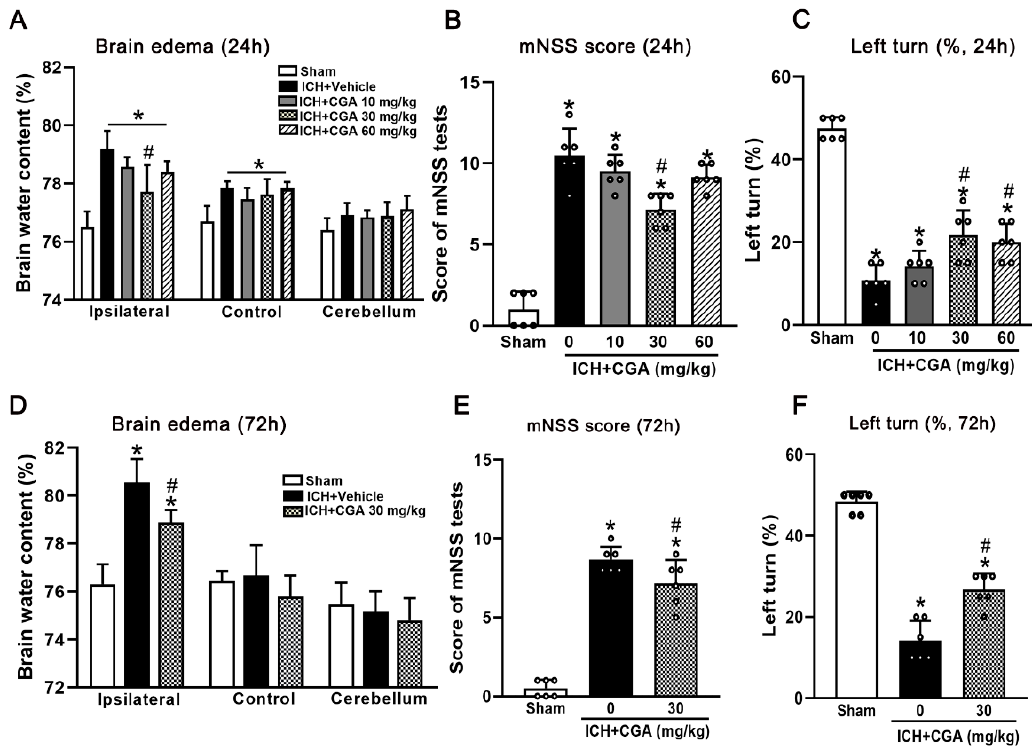
Figure 2. The effects of CGA on brain water content and neurobehavioral outcomes after ICH. ( A ) Brain water content. ( B ) Score of mNSS tests at 24 h. ( C ) Left Turn test at 24 h after ICH. ( D ) Brain water content, ( E ) Score of mNSS tests at 72 h. ( F ) Left Turn test at 72 h after ICH. * p < 0.05 vs. sham, # p < 0.05 vs. ICH + vehicle. Data are presented as the mean ± SD. n = 6 per group.